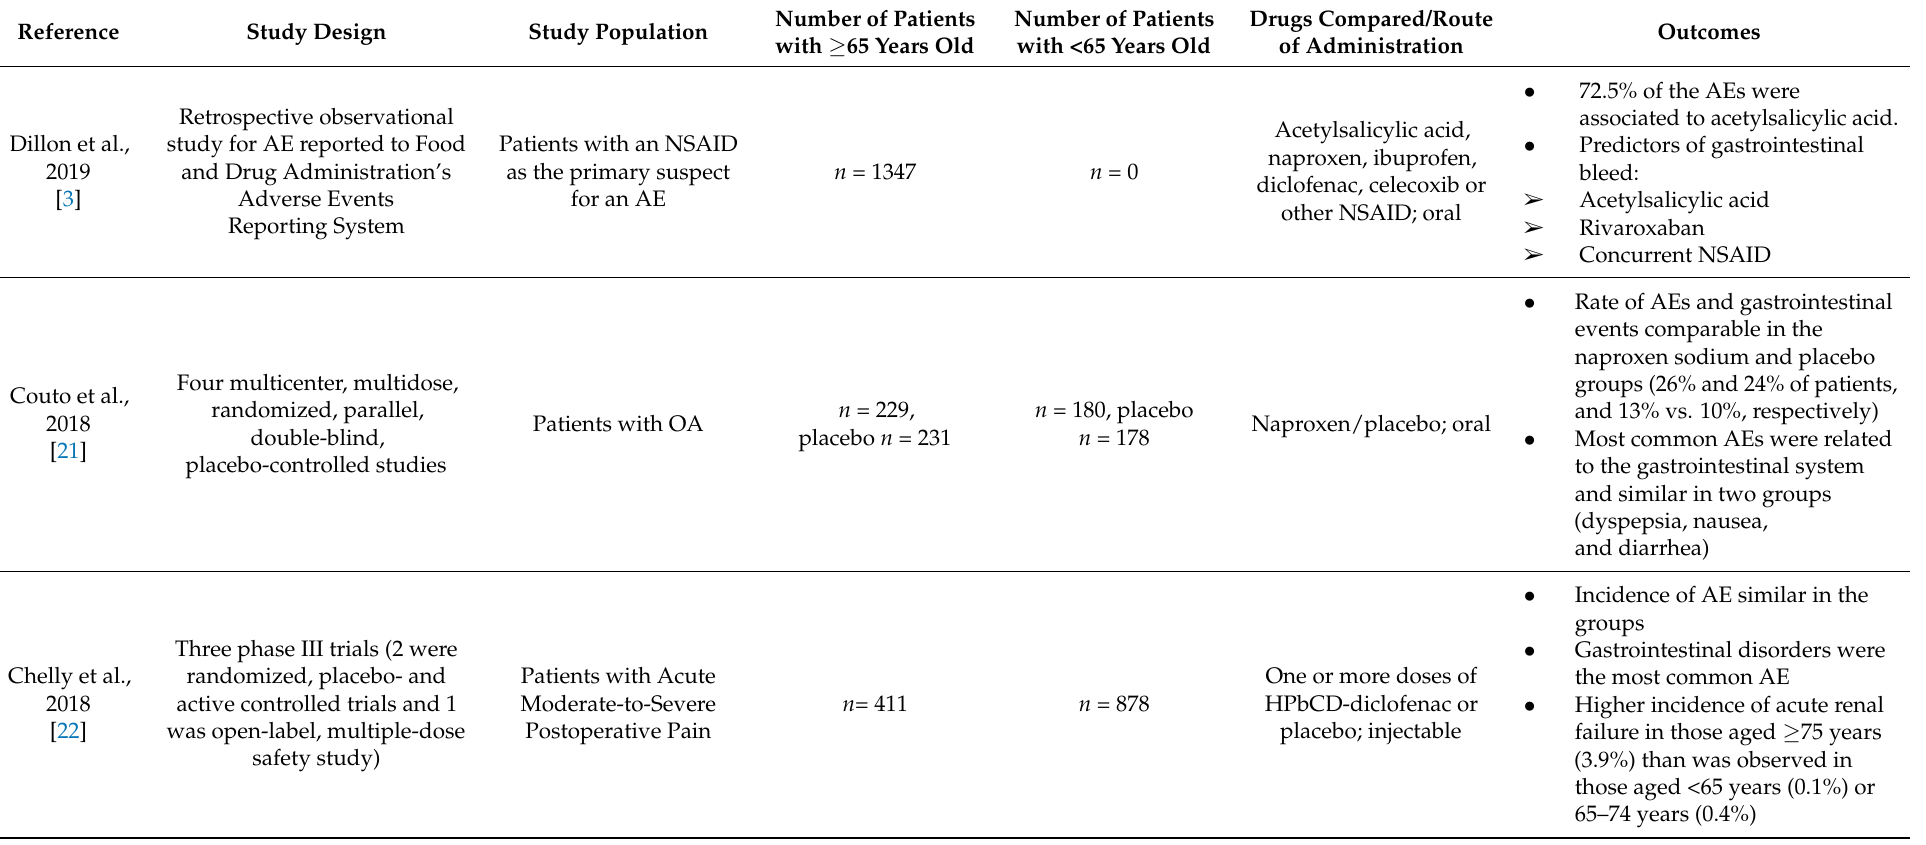
Table 1. Studies evaluating the safety of non-steroidal anti-inflammatory drugs (NSAIDs) in the